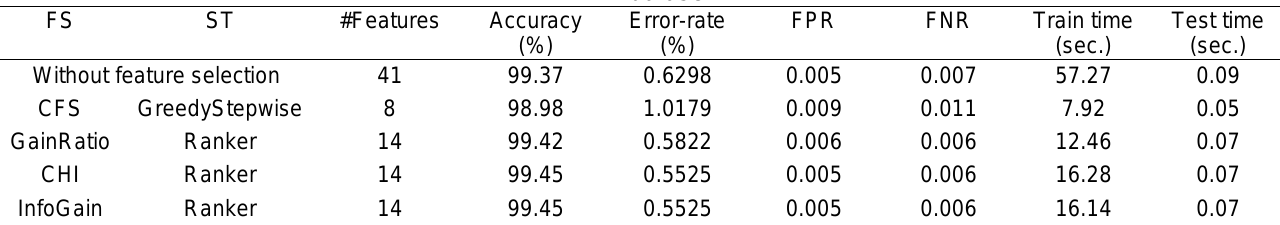
Table 9. Performance evaluation of J48 classifier using and without using feature selection techniques on NSL-